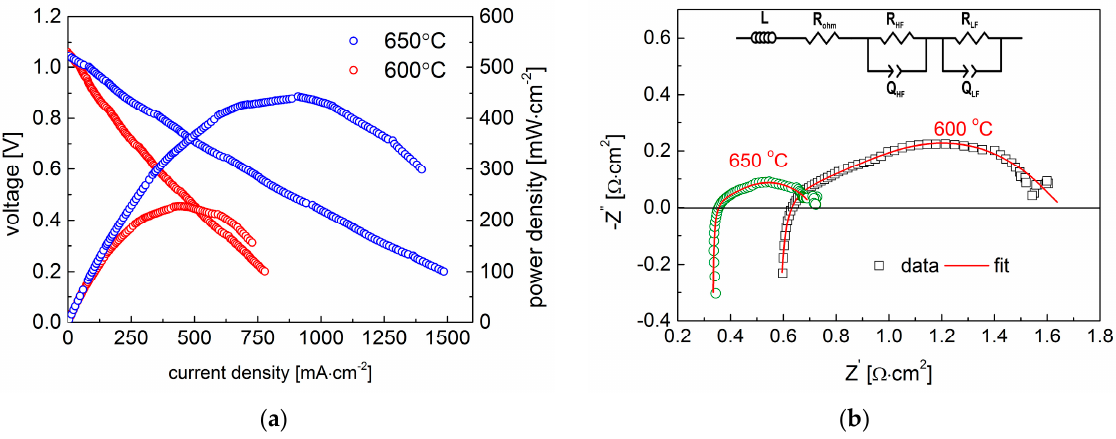
Figure 12. ( a ) Voltage and power density as a function of current density and ( b ) impedance spectra for anode-supported SOFC with La 0.95 Sr 0.05 Ni 0.5 Cu 0.5 O 3 −δ -based cathode.